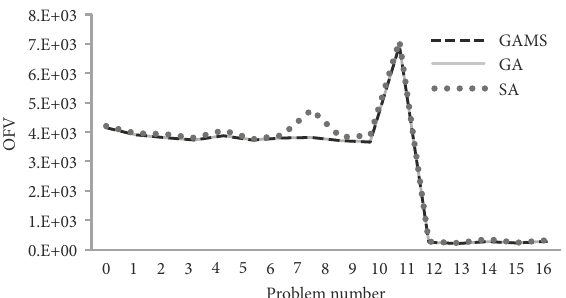
Figure 14. Comparison of computational times for the GAMS